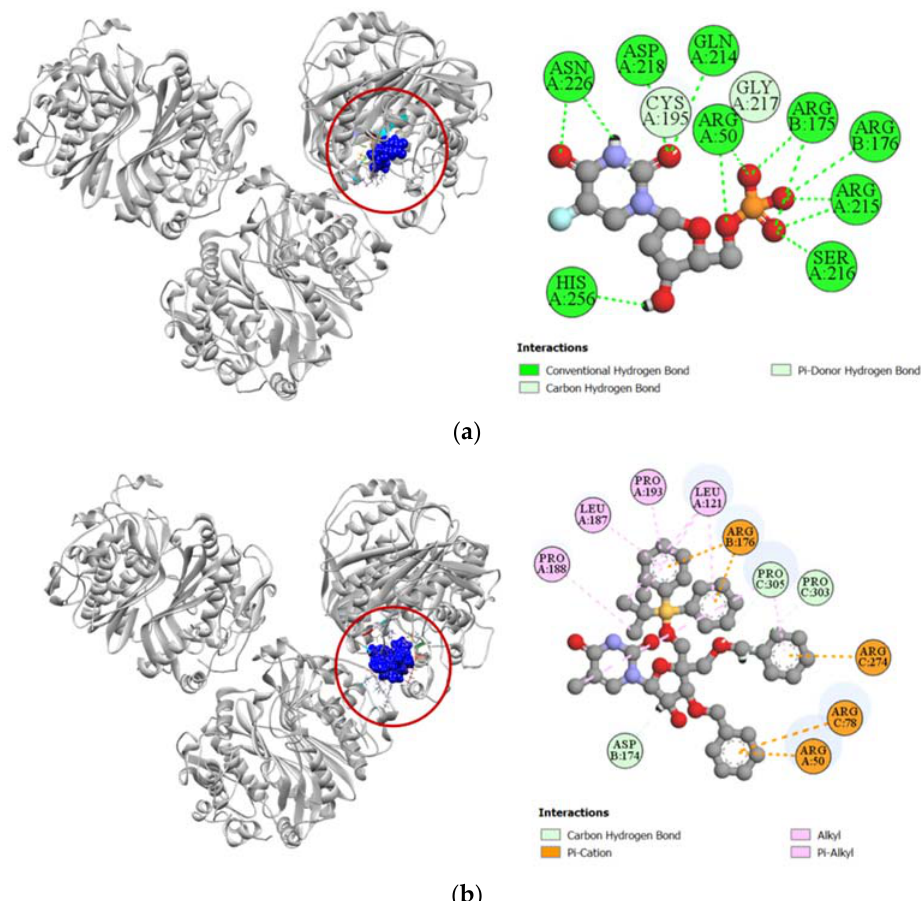
Figure 9. Pictorial representation (2D and 3D) of docking results for best-ranked pose of key inter- actions of ligands with the binding pocket of human thymidylate synthase (PDB: 6ZXO). ( a ) 5-fluorodeoxyuridine monophosphate with 6ZXO; ( b ) compound 6 with 6ZXO.